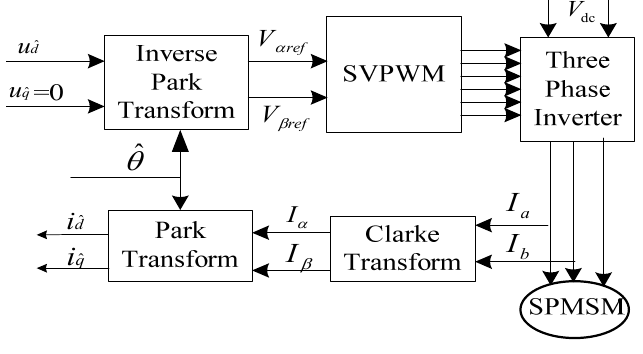
Figure 5. Initial rotor position estimation